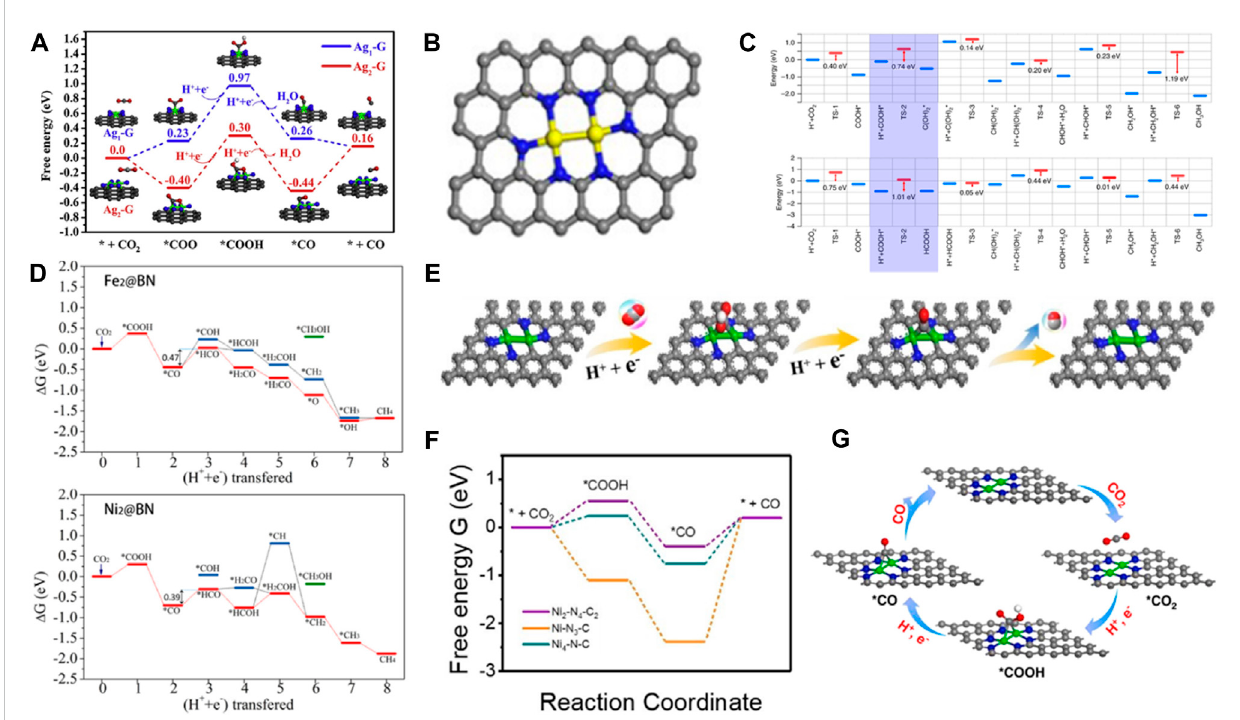
FIGURE 7 (A) FreeenergydiagramsofCO 2 reductiononAg 1 -GandAg 2 -Gcatalyst( fi gureusedwithpermissionfromLietal.,2020a). (B) Thedi-atomicmodels used in EXAFS spectrum fi tting ( fi gure used with permission from Cao et al., 2020). (C) The CO 2 reaction paths for Pt 1 /MoS 2 and Pt 2iii /MoS 2 ( fi gure used with permission from Li et al., 2018) (D) Free energy pro fi les of CO 2 hydrogenation on Fe 2 @BN and Ni 2 @BN nanosheet ( fi gure used with permission from Zhou et al., 2020a) (E) Reaction paths for CO 2 reaction to CO on Ni 2 -N 4 -C 2 catalyst. Gray, C; red, O; blue, N; while, H; green, Ni. (F) Free-energy diagram of CO 2 RR to CO ( fi gure used with permission from Zhang et al., 2022c). (G) Scheme diagram of CO 2 electroreduction to CO on Ni 2 – N 3 (Ni 2 - NCNT) ( fi gure used with permission from Lu et al.,